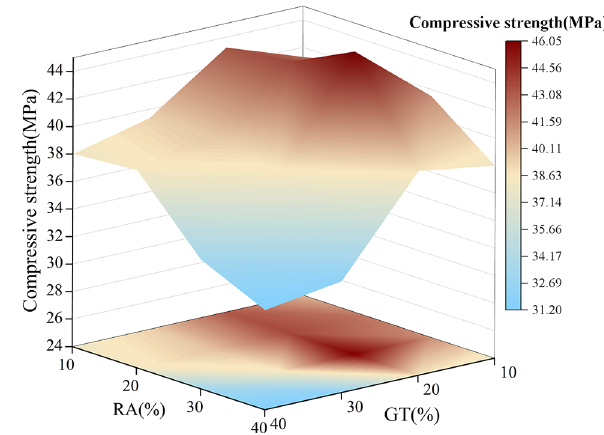
Figure 6: Initial slump of GTRAC.